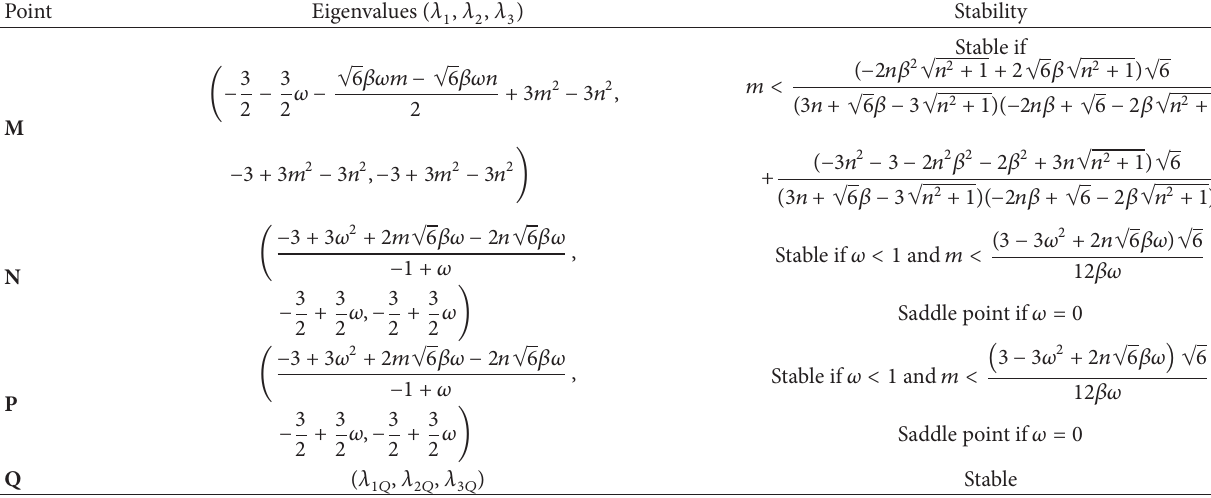
Table 2: Eigenvalues and dynamical characters of the fixed points.